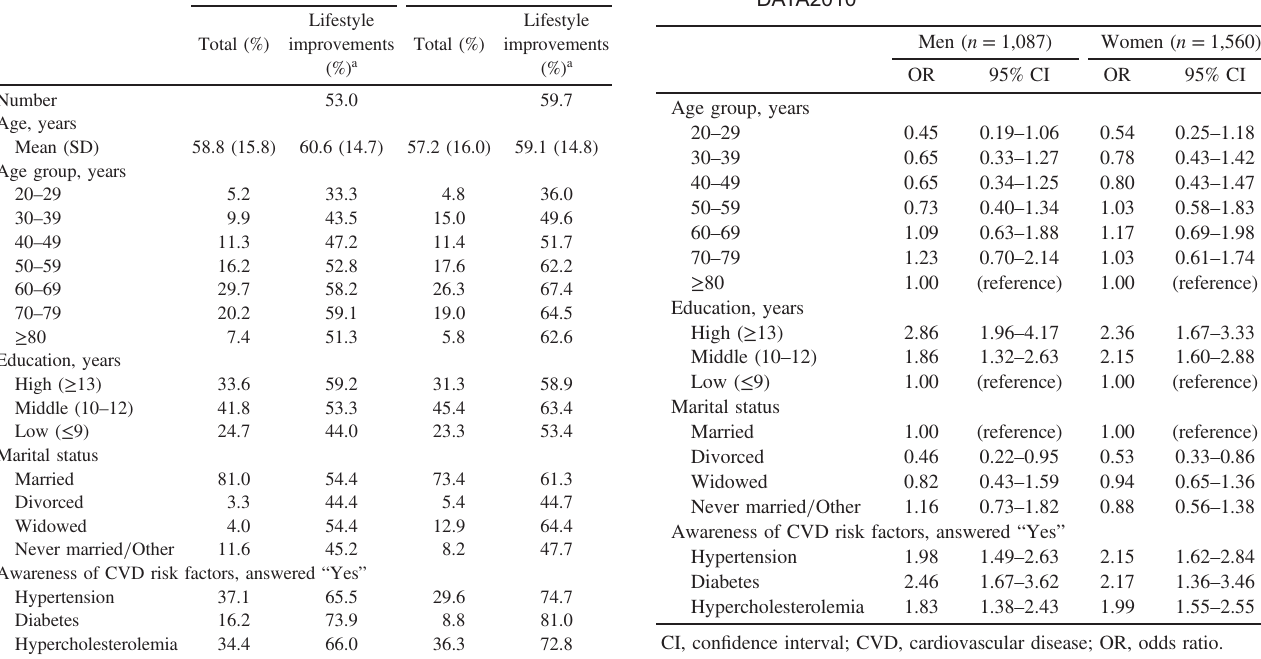
Table 2. Odds ratios and 95% con fi dence intervals of answering “ yes ” to the question of lifestyle improvements in the multivariable logistic regression analysis: